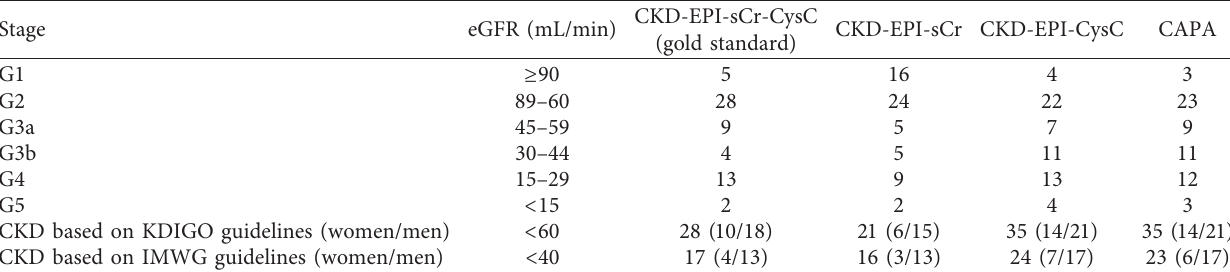
Table 2: Chronic kidney disease stage classification of patients with newly diagnosed multiple myeloma depending on the equation